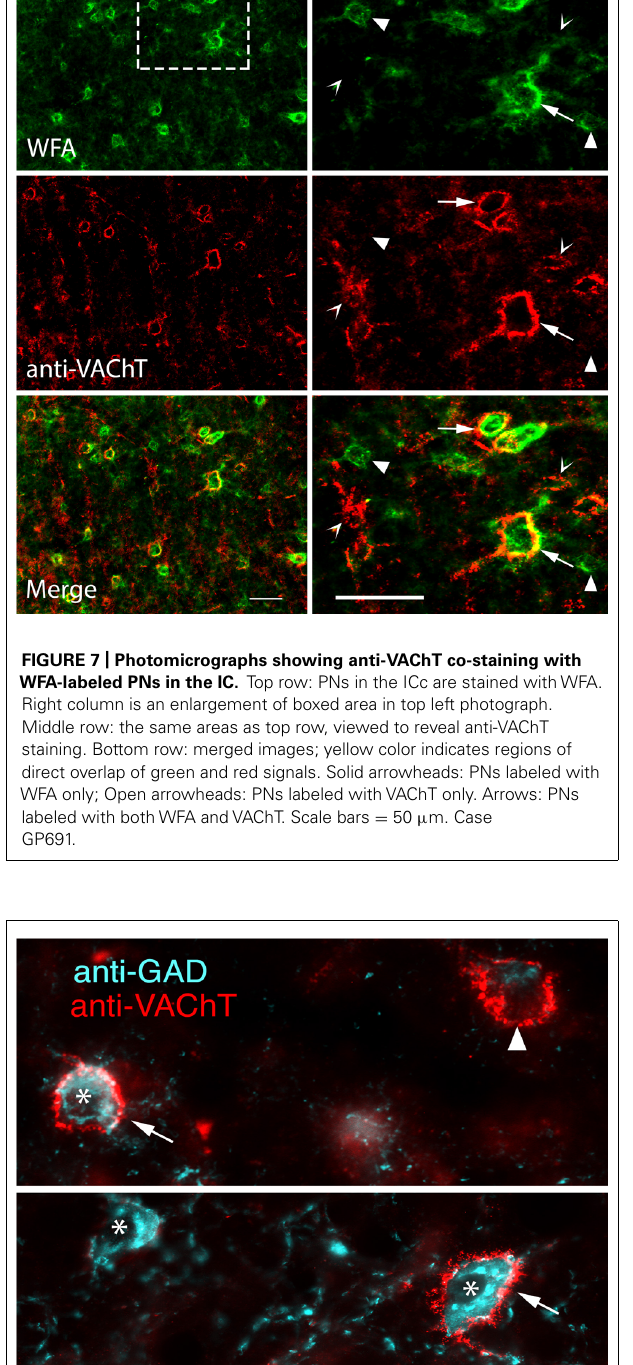
1996). Glutamatergic cells make up about 75% of IC cells in guinea pigs (unpublished observations). Combining this